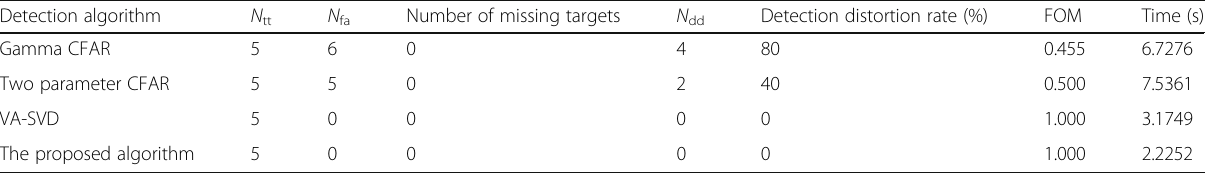
Table 2 Comparison of detection performance among the four detection algorithms Detection algorithm